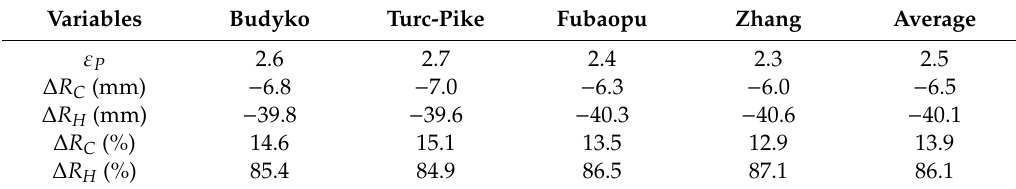
Table 5. Separating the effects of climate change and human activities by climate elasticity method. Variables